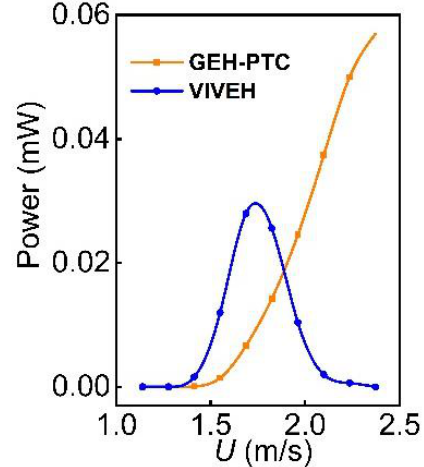
Figure 5. The output power comparison of the GEH-PTC and the VIVEH in experiment.